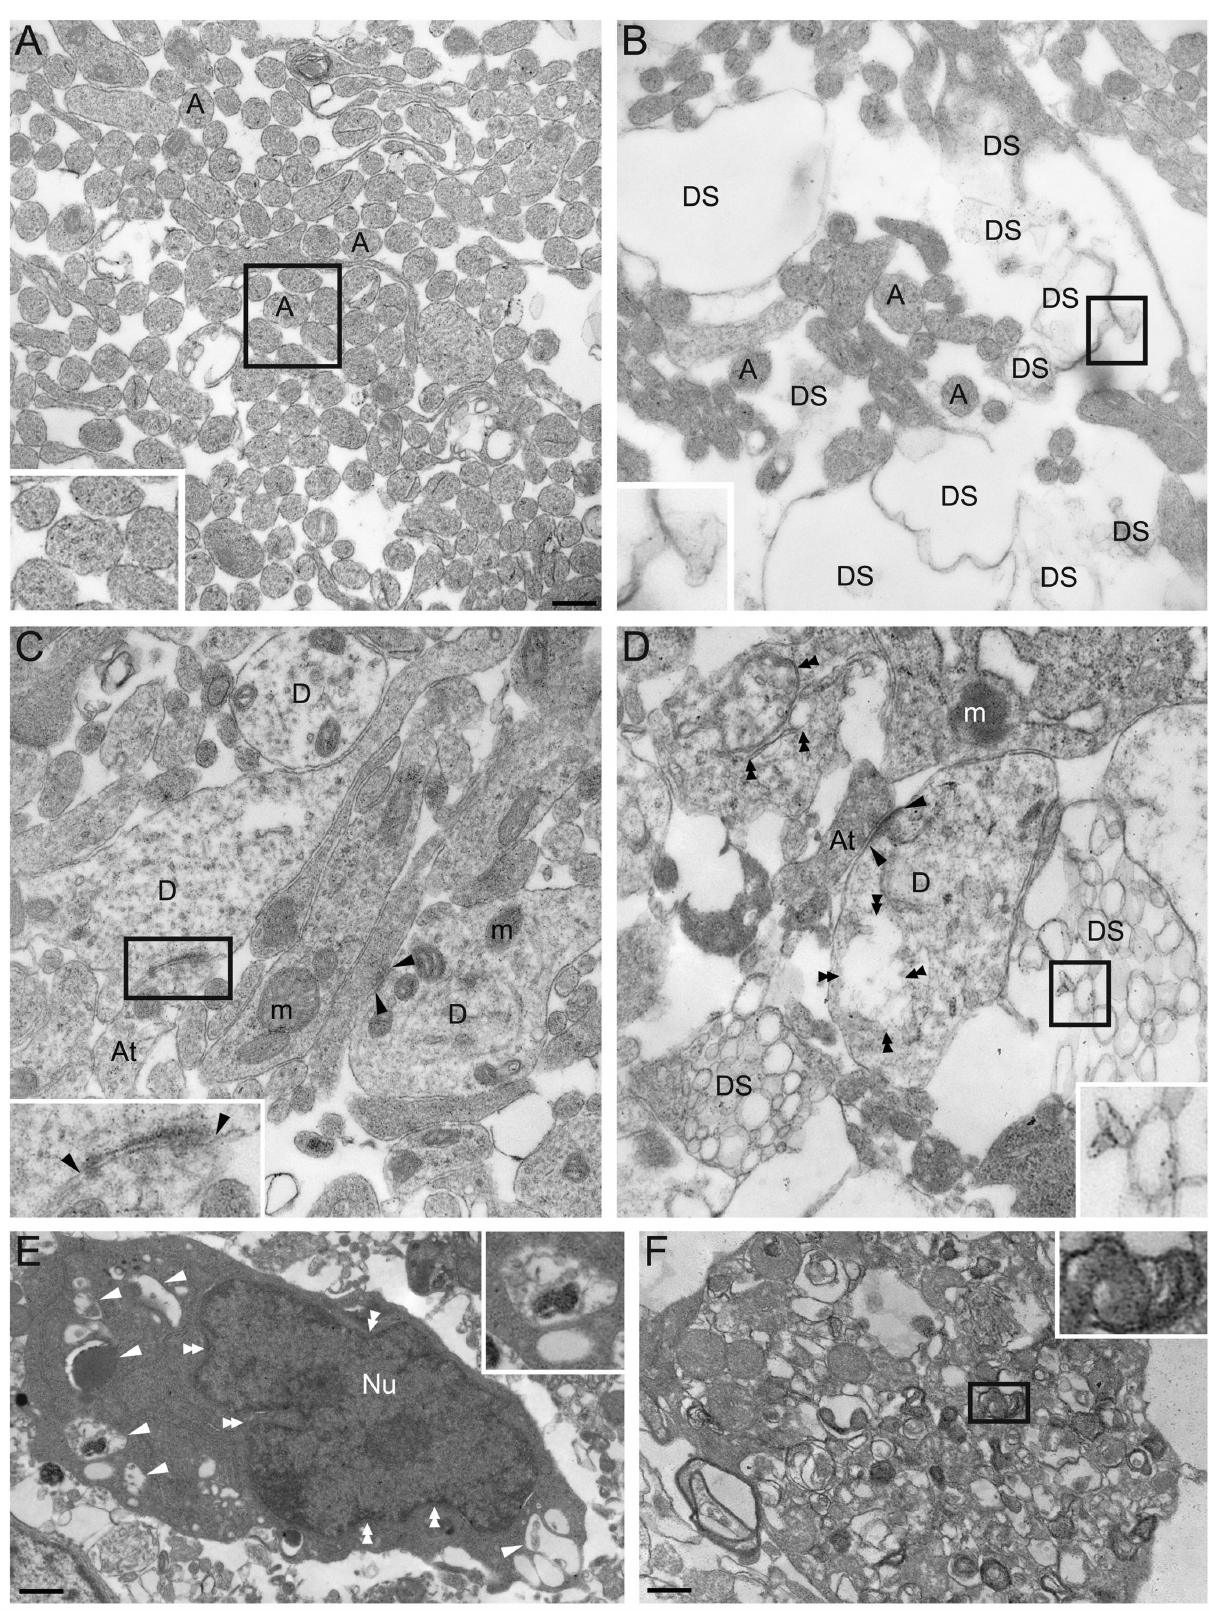
Figure 3. Ultrastructure of SCC and sham control spinal cords 1 day after injury. (A) Axon profiles in the ventrolateral white matter in sham control at P2. Note the presence of filament-like structures within the axon cytoplasm (inset). (B) Ventrolateral white matter in a SCC spinal cord 1 day